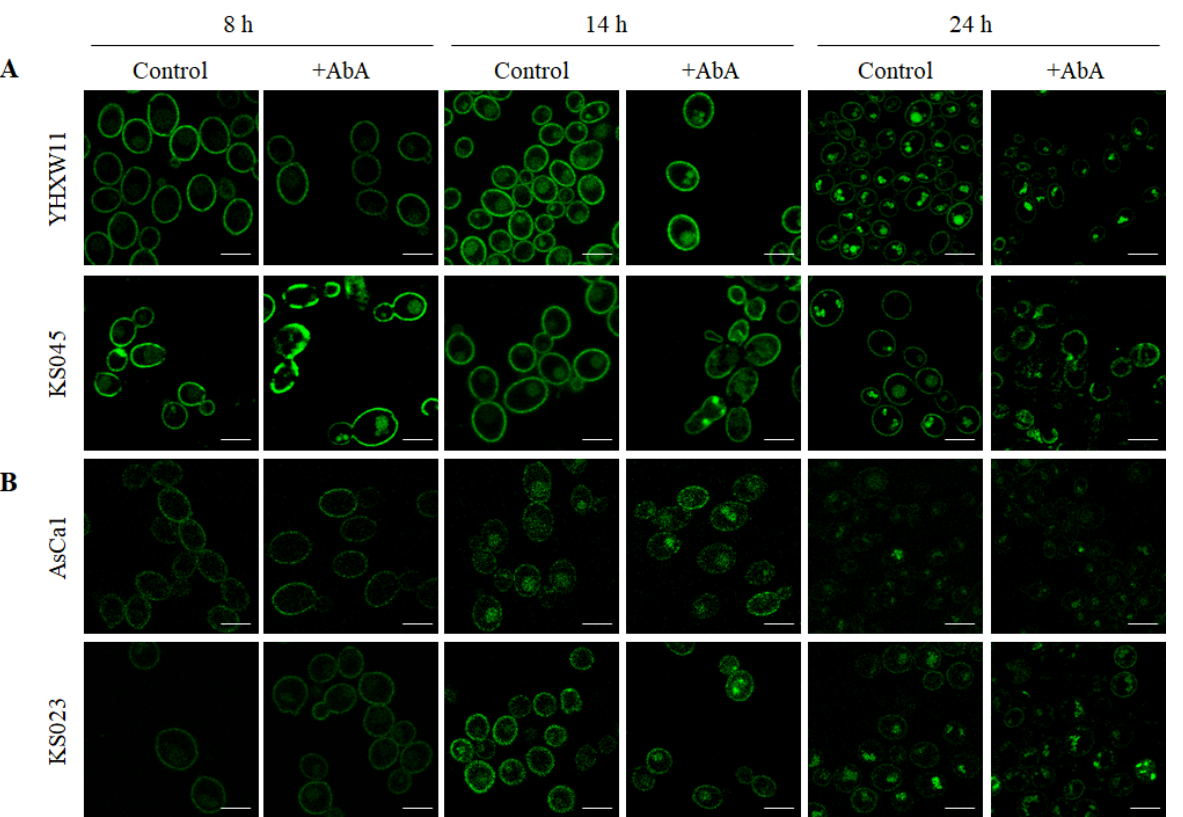
Figure 5. Subcellular localization of Pma1-GFP ( A ) and Cdr1-GFP ( B ) in C. albicans CAF2-1 (YHXW11 and AsCa1) and erg11 ∆ / ∆ (KS045 and KS023) strains after 8, 14, and 24 h of culture under control conditions or after treatment with AbA (0.05 μ g/mL). Microphotographs were obtain using confocal microscopy. Scale bar 5 μ m.